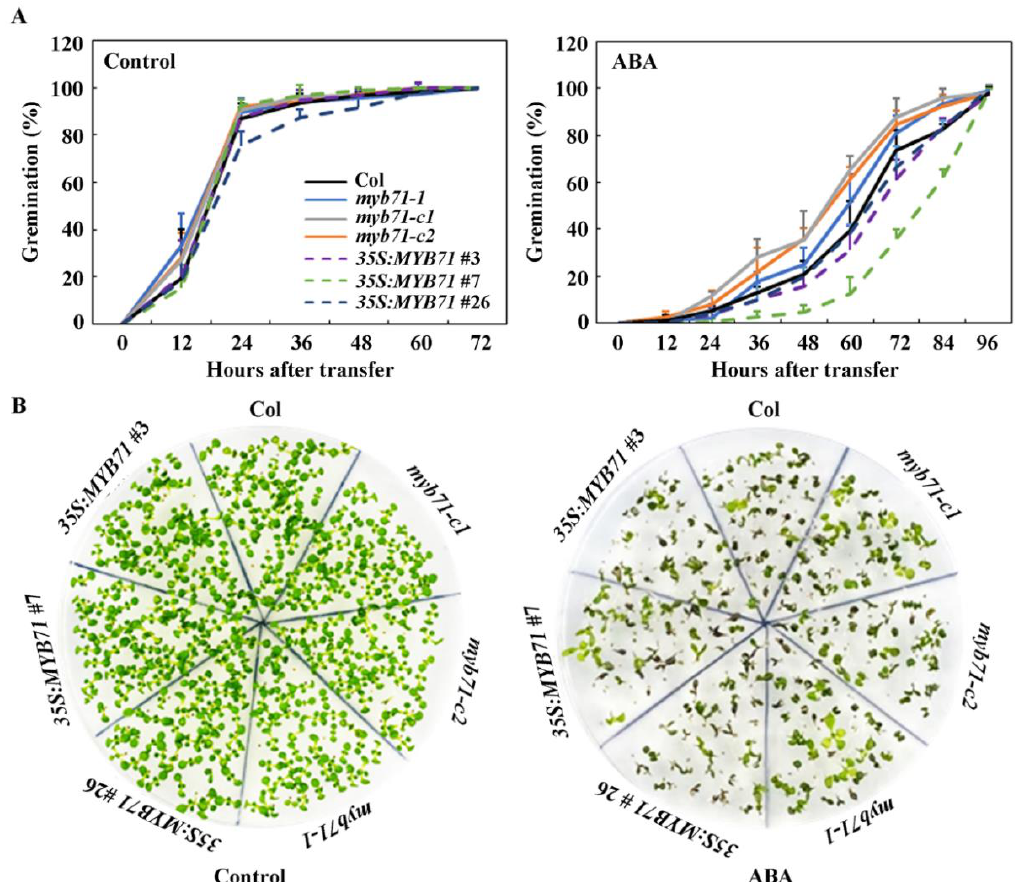
Figure 5. Effects of ABA on seed germination and cotyledon greening of the Col wild type, the 35S:MYB71 transgenic plants and the MYB71 single mutants. ( A ) Effects of ABA on seed germination of the Col wild type, the 35S:MYB71 transgenic plants, and the MYB71 single mutants. Sterilized seeds of the Col wild type, the 35S:MYB71 transgenic plants, and the MYB71 single mutants were plated on 1/2 MS plates with or without 1 µM ABA. The plates were kept at 4 °C and in darkness for 2 days, and then transferred to a growth room. The number of seeds germination was counted at the time points indicated, and percentage of germination was calculated. Data represent the mean ± SD of three replicates. ( B ) Effects of ABA on cotyledon greening of Col wild type, the 35S:MYB71 transgenic plants, and the MYB71 single mutants. Pictures were taken 12 days after the transfer.